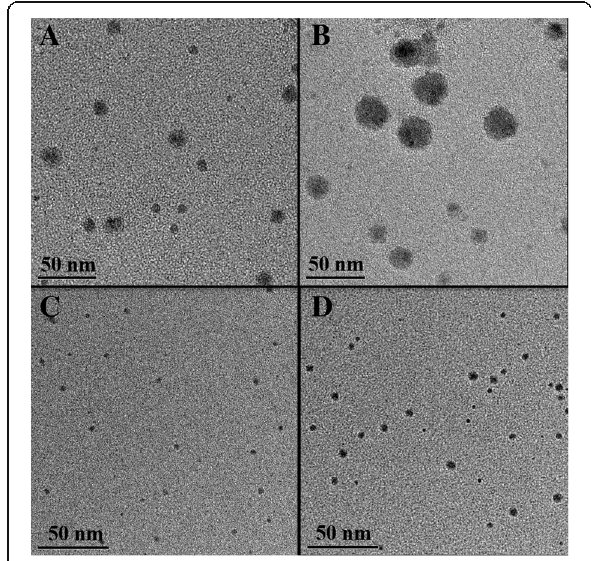
Fig. 4 TEM image of a , b linear copolymers and c , d star copolymers micelles stabilized AgNPs at different PDMAEMA/AgNO 3 molar ratios: a , c 6/1, b , d 1/1